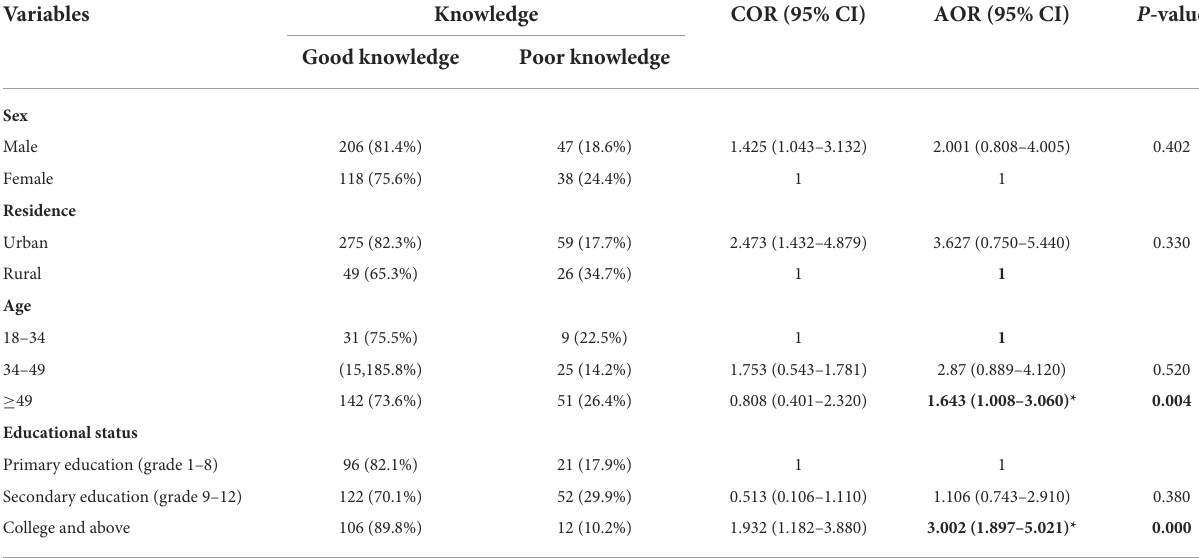
TABLE 3 Factors associated with knowledge about COVID-19 vaccine among patients with chronic diseases, southern Ethiopia, 2021 ( N = 409).